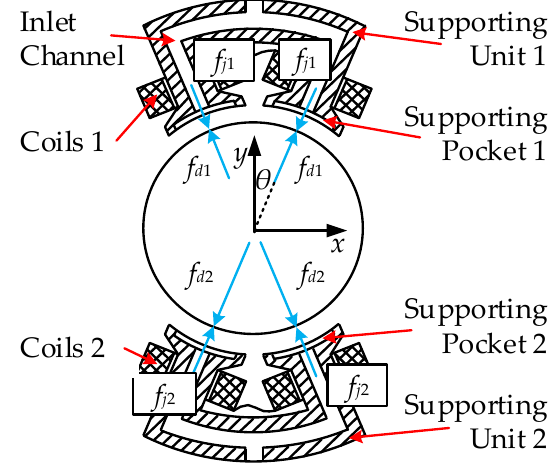
Figure 7. Force diagram of y -direction supporting system.